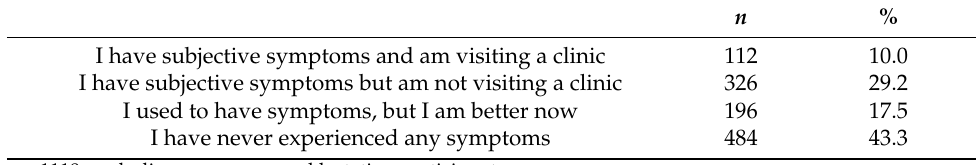
Table 6. Subjective symptoms suggestive of menopause among estrogen-like supplement